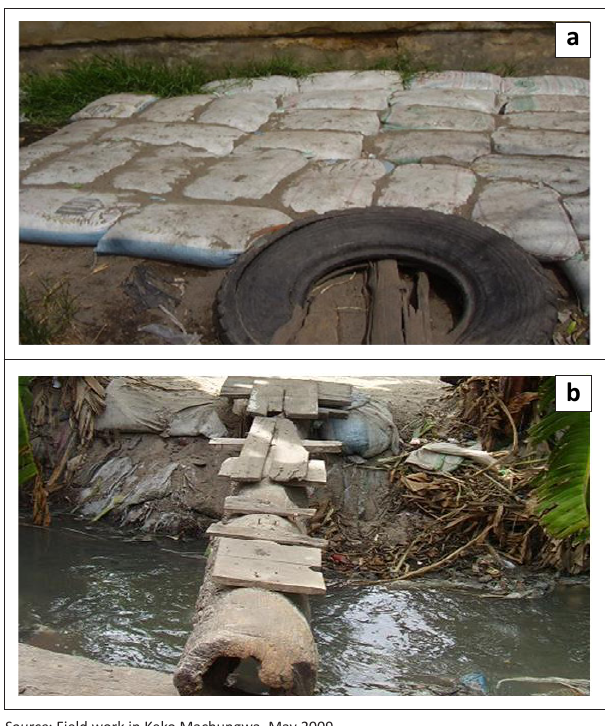
FIGURE 7: (a) Pit latrines (b) raised from plinth